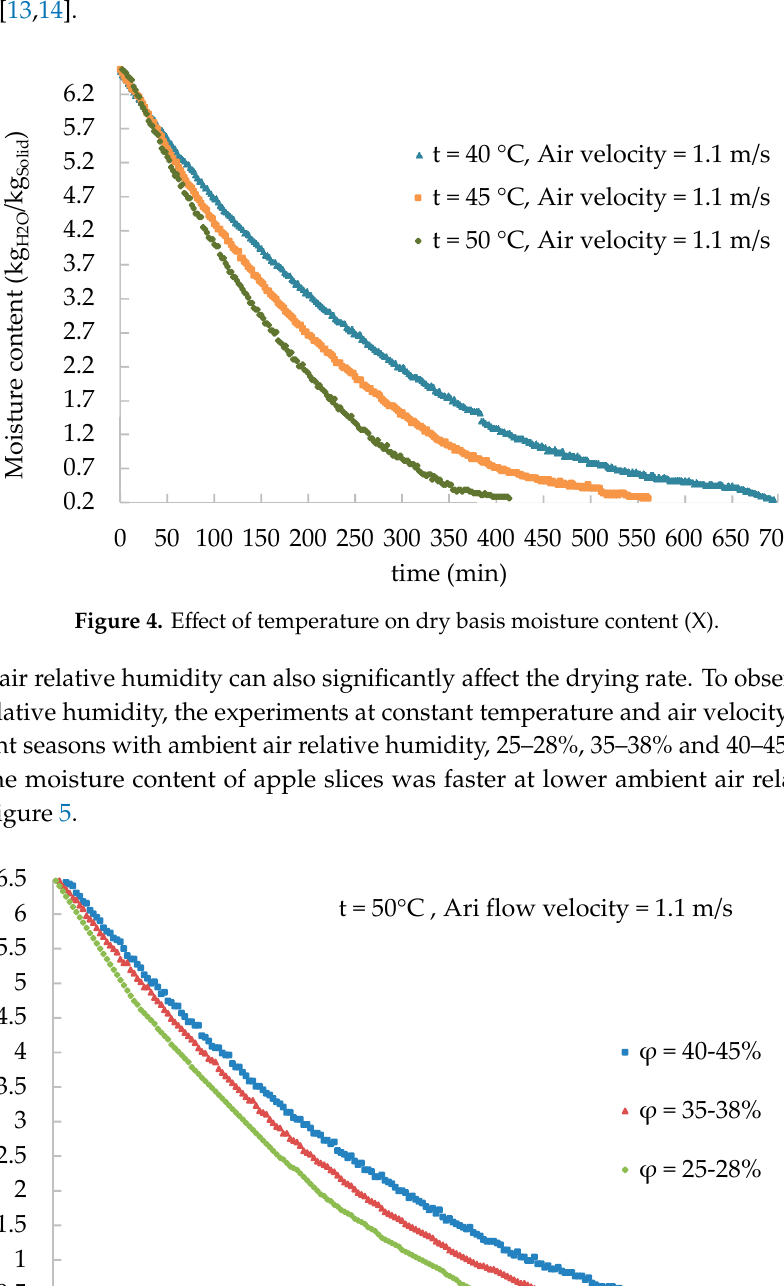
Figure 3. Effect of air velocity on dry basis moisture content (X).